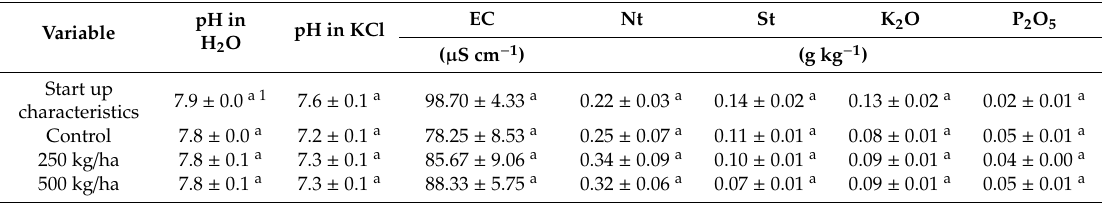
Table 1. Basic combustion waste technosol